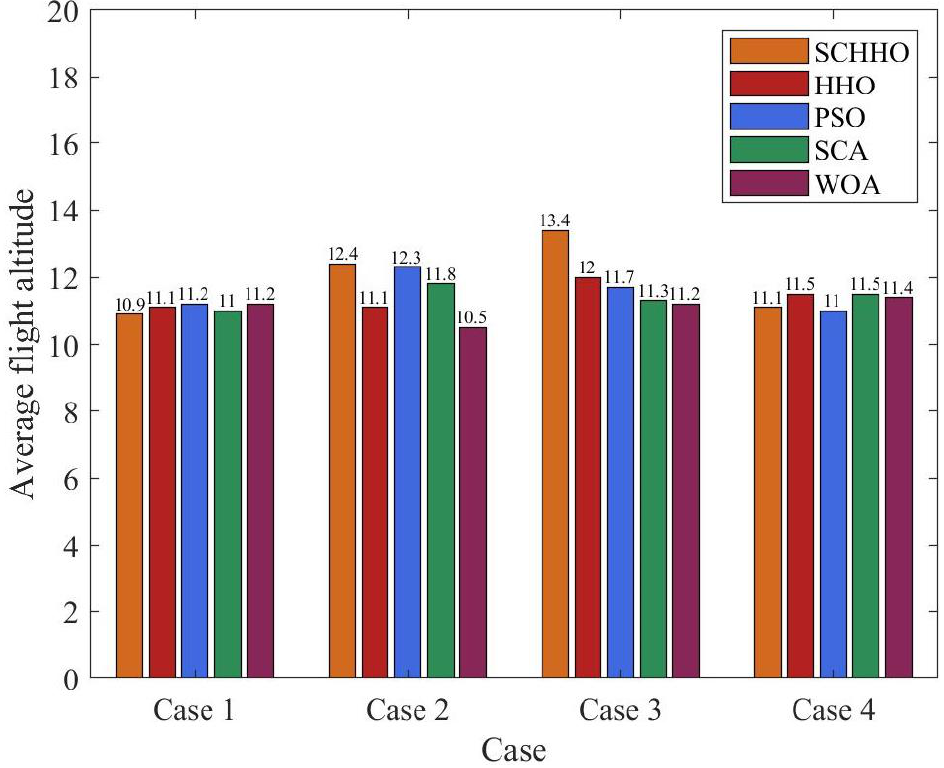
Figure 11. Average height comparison.